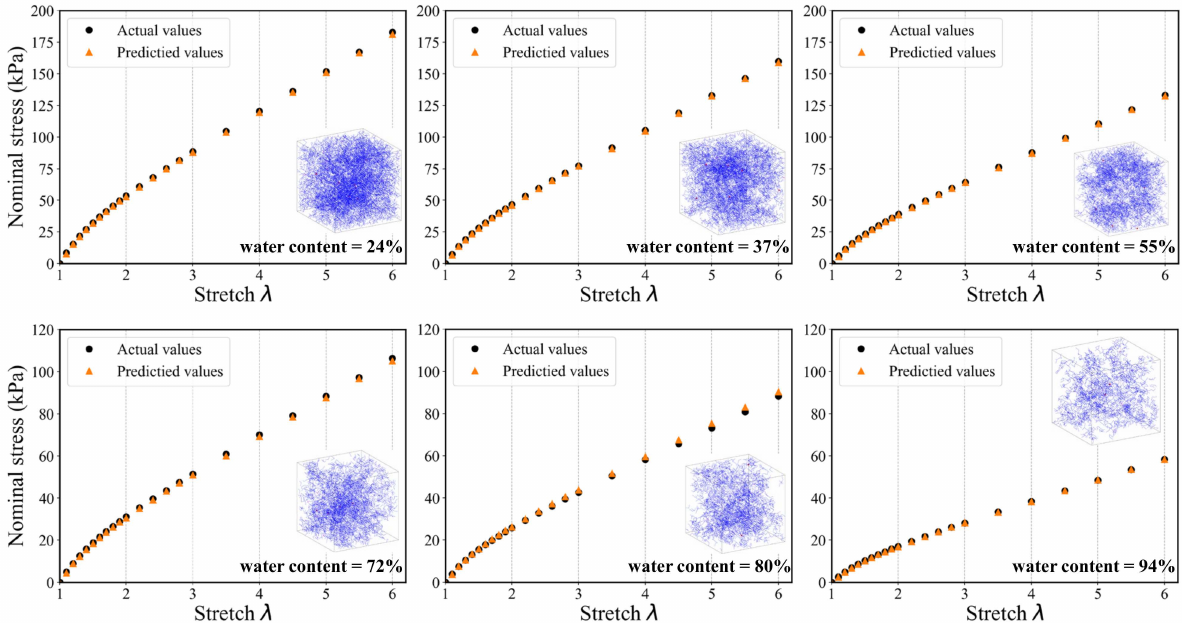
Figure 15. A randomly generated set of six SAW models and corresponding stress–stretch curves for the 3D CNN model prediction compared to the actual